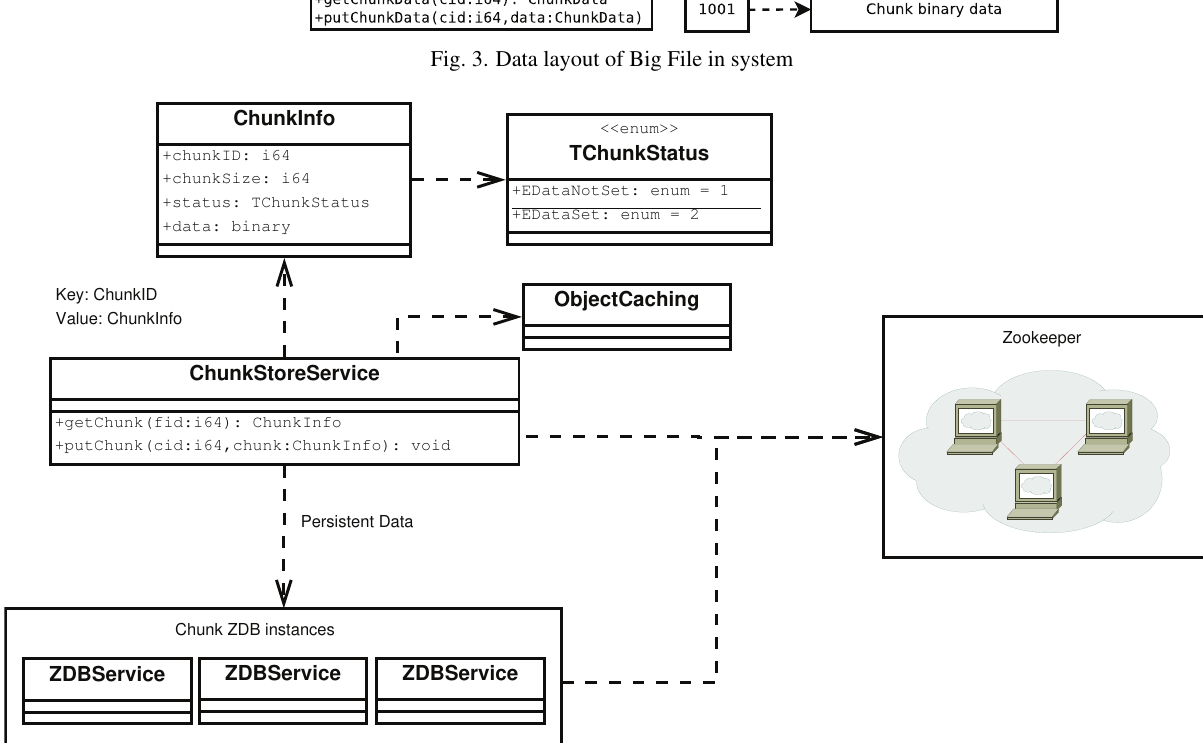
Fig. 3. Data layout of Big File in system